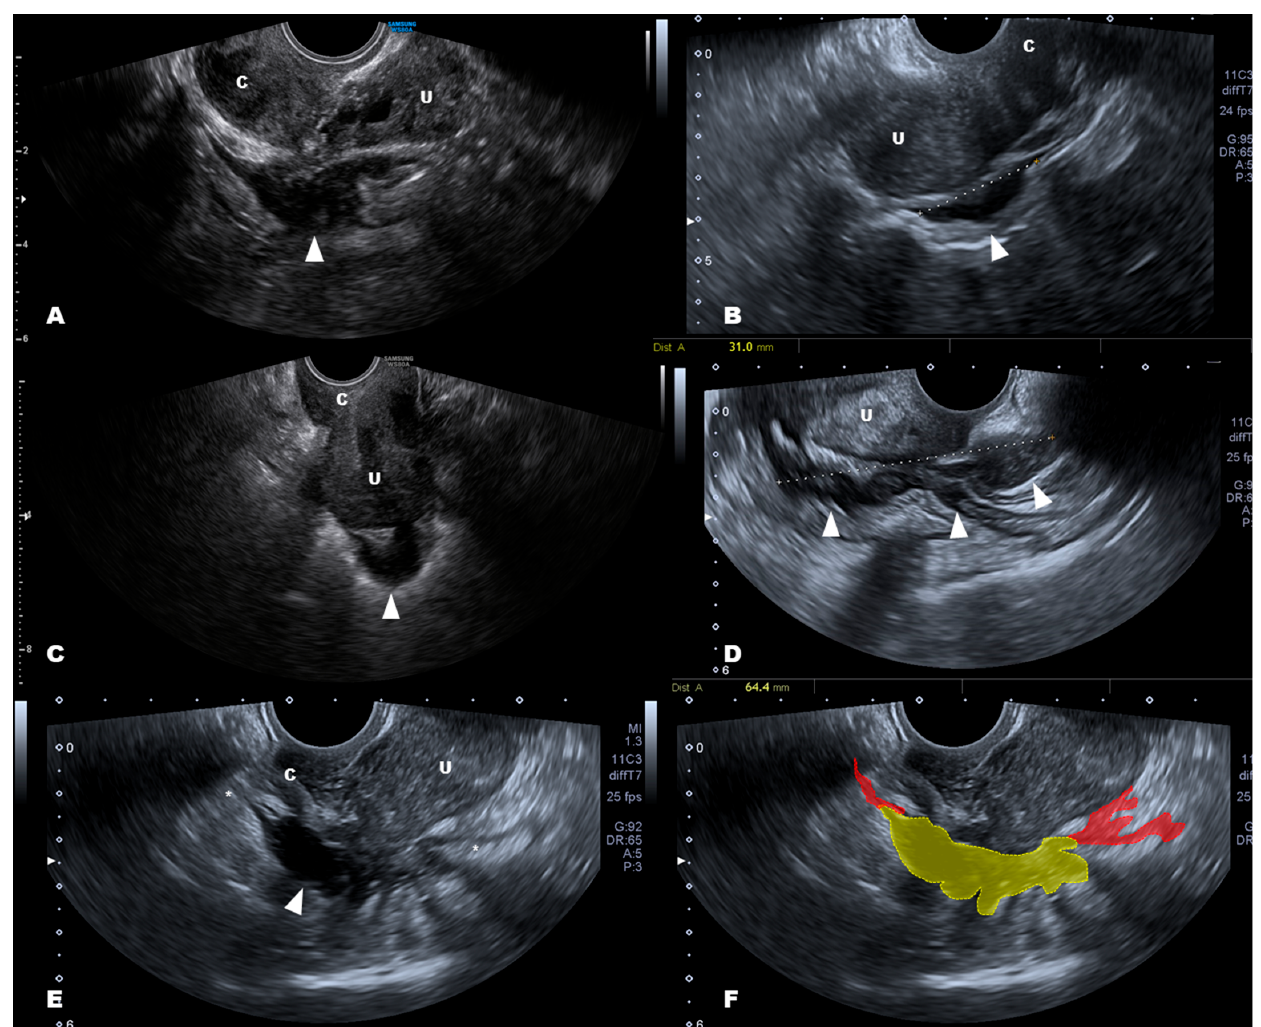
Figure 1. Deep infiltrating endometriosis of the colorectum. ( A , B ) show, respectively, typical nodules (arrow) of the medial and the proximal part of the rectum. ( C ) shows an endometriosis nodule of the sigmoid colon. ( D ) shows a large nodule that involves the rectum, from proximal to distal, and the distal sigmoid. ( E ) shows a nodule that involves the medial and proximal part of the rectum (arrow) with long fibrotic tails (*); ( F ) is explains ( E ) where the nodule is in yellow and the fibrotic tails are in red. Abbreviations: U uterus; C cervix.